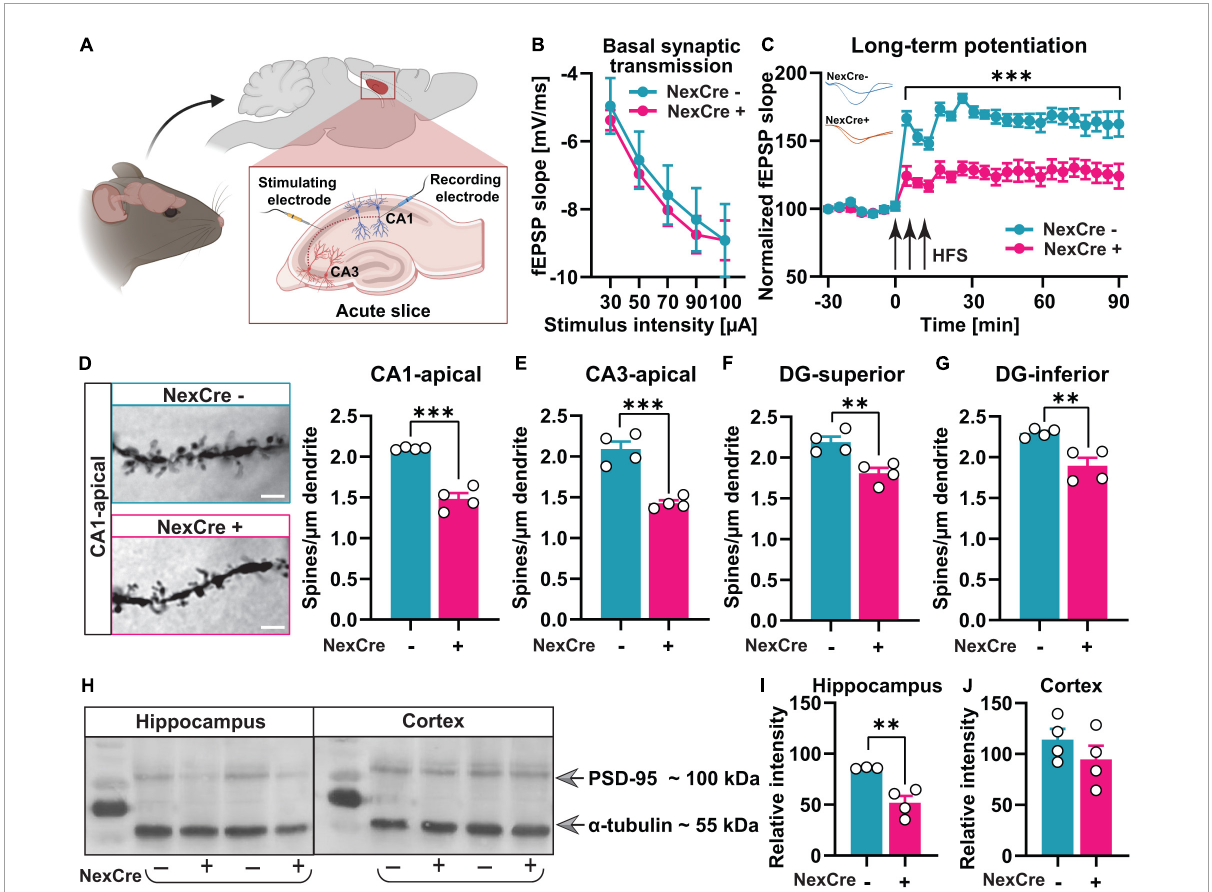
FIGURE3 Absence of TTL in neocortex and hippocampus results in impaired synaptic plasticity and reduced density of dendritic spines. (A) A schematic overview of the location of stimulating and recording electrodes in acute hippocampal slices (the figure was created using BioRender.com). (B) Input-output curves of field excitatory postsynaptic potential (fEPSP) slopes in 7–10 hippocampal slices obtained from both tested groups did not show any significant differences. (C) LTP measurements in acute hippocampal slices from 4 to 5-month-old TTL lox / lox / NexCre + and control mice showed severe LTP impairment. FEPSPs (normalized to baseline values) from 7 to 10 slices each of the TTL lox / lox / NexCre + and control mice before and after high-frequency stimulation (HFS) are shown. (D–G) Brains of the 4–5-month-old TTL lox / lox / NexCre + and